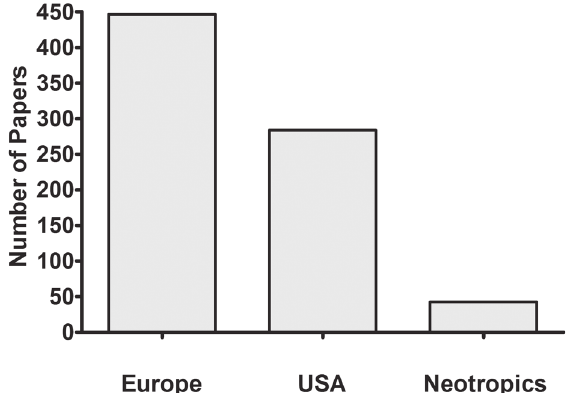
Figure 1 - Total number of scientific articles published between January 1990 and July 2015 by authors from selected european countries, USA and from six countries of the Neotropical region that used microsatellite markers for studies of birds, involving population genetics, behavior/kinship and/ or the characterization of microsatellites